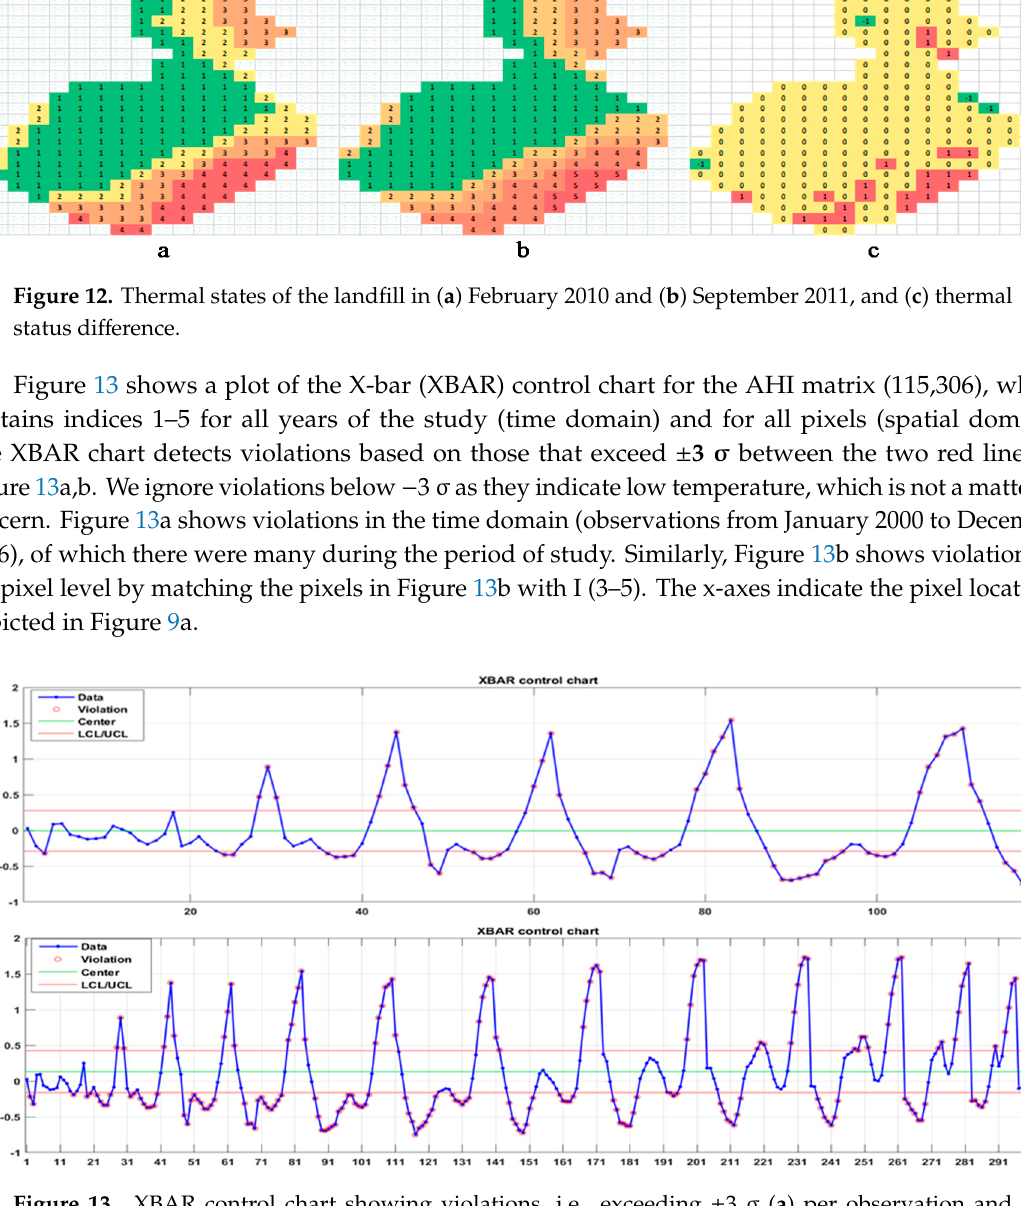
Figure 13. XBAR control chart showing violations, i.e., exceeding ±3 σ ( a ) per observation and ( b ) per pixel.